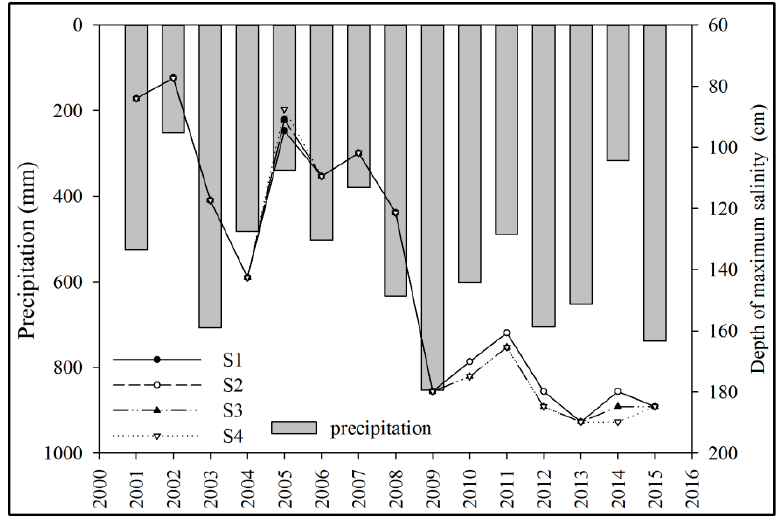
Figure 6. Variation in the depth of maximum EC e in the soil profile at maize harvest along with precipitation over a 15-year period of winter wheat-summer maize growing seasons in Hebei Low Plains in North China.